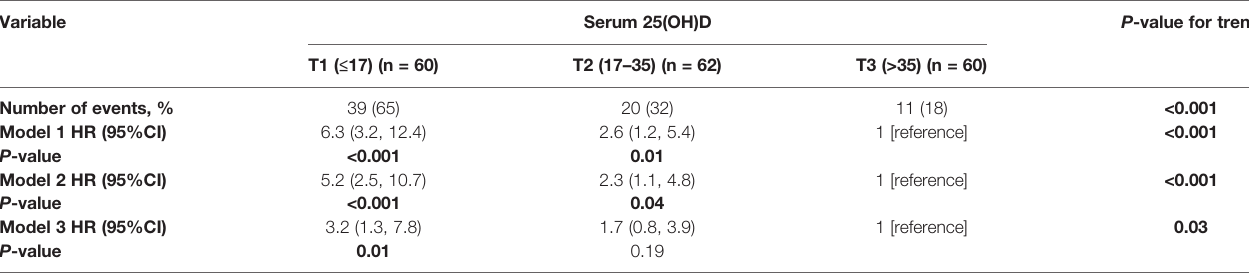
Model 3: Model 2 plus age, gender, HbA1c, 24-h urinary protein, SBP, use of RAAS inhibitor, oral hypoglycemic agents, and insulin. A two-tailed P < 0.05 was considered statistically signi fi cant and presented in